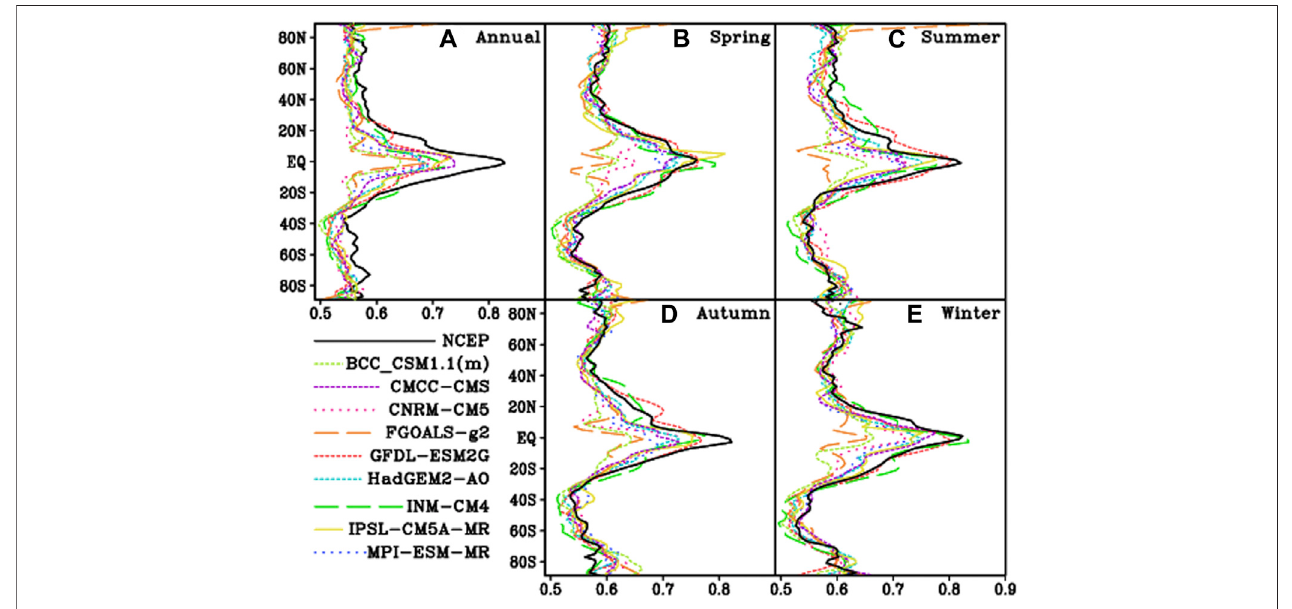
FIGURE 5 | Zonal distribution of daily precipitation ’ s scaling exponents obtained from NCEP and nine CMIP5 models for (A) year; (B) spring; (C) summer; (D) autumn; (E) winter.